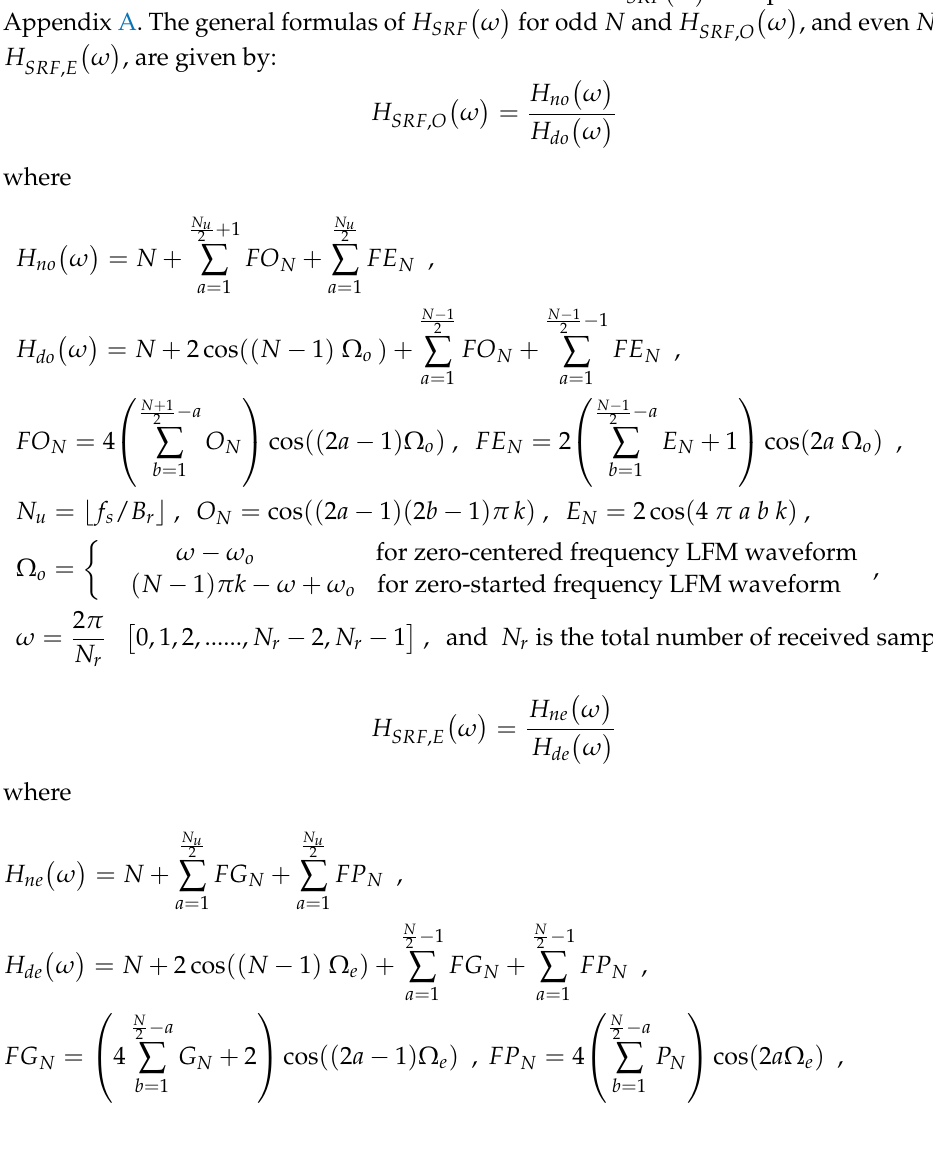
Figure 9. The enhanced matched filter output in frequency and time domains: ( a ) Y SRF ( b ) xr N ( m ) , and y SRF ( m )